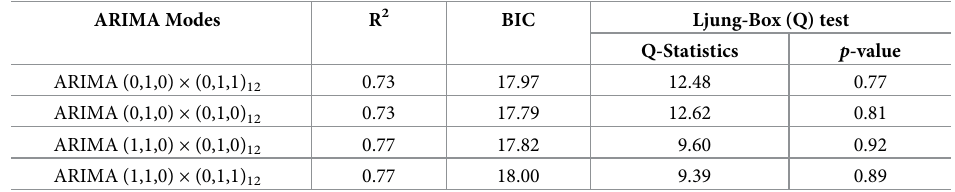
Table 3. Parameter estimation of candidate ARIMA